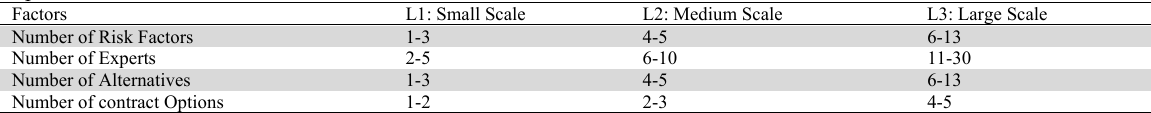
Experiment for validation of the